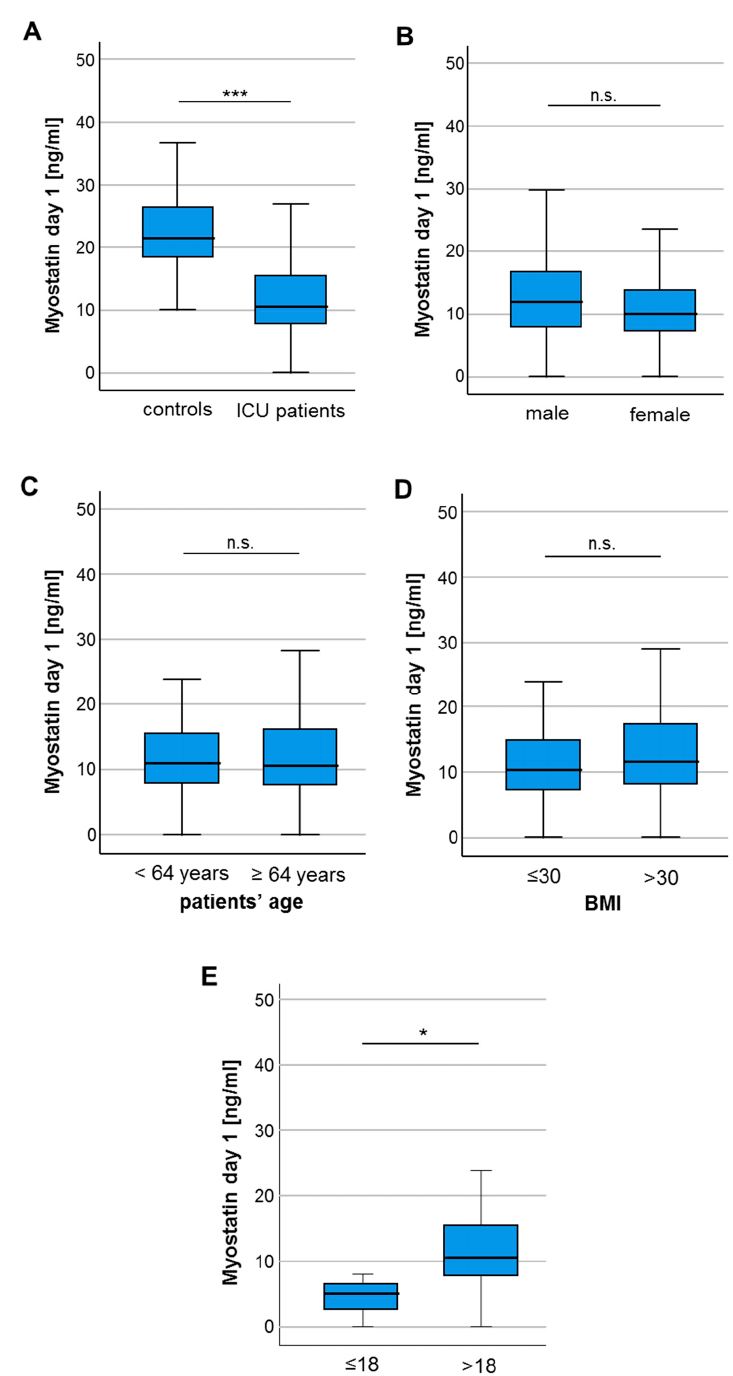
Figure 1. Myostatin serum levels are significantly lower in critically ill patients. ( A ) Critically ill patients at admission to the ICU have significantly lower myostatin serum levels compared to healthy controls. ( B ) Myostatin serum concentrations did neither di ff er between male and female patients, nor between patients younger or older than 64 years ( C ), patients with a body mass index (BMI) below or above 30 ( D ) but for patients with a BMI below or above 18 ( E ). Asterisks indicate p values (Mann-Whitney U-test): * p < 0.05, *** p <